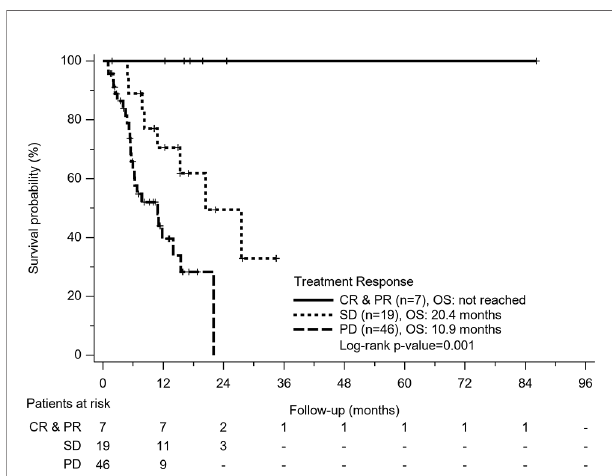
FIGURE 3 | Kaplan-Meier survival curves of treatment response in all patients. Patients who obtained complete response (CR) or partial response (PR) had obvious survival bene fi ts than patients with stable disease (SD) and patients with progression disease (PD) (p=0.001).